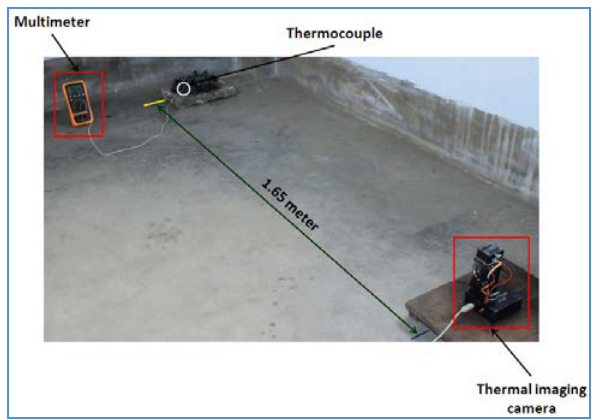
Figure 5. Experimental setup with distance of 1.65 meter